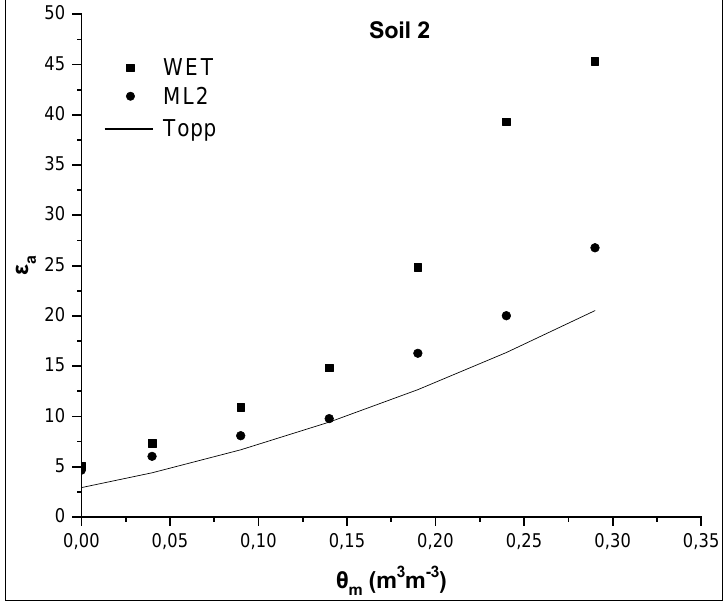
Figure 3. Comparative presentation of relationships θ m - ε a obtained by the WET sensor, the ML2 sensor and the TOPP equation for soil 2.